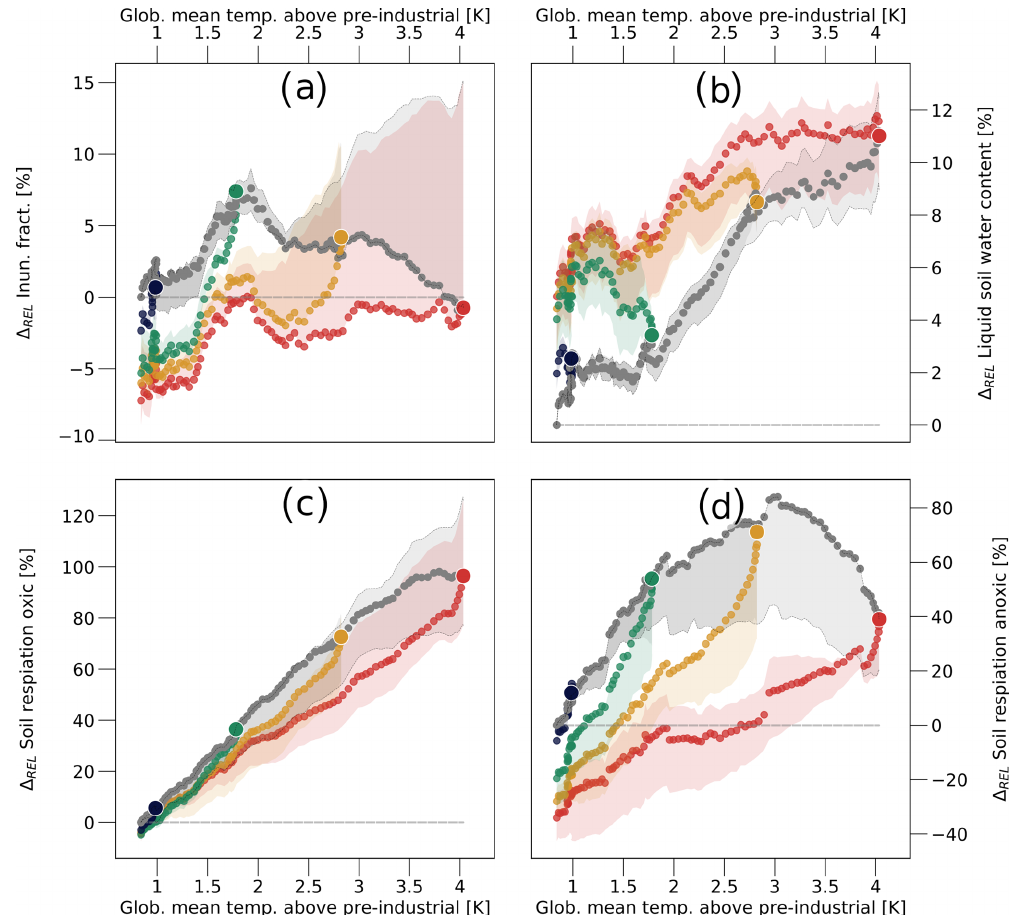
Figure 9. Soil CH 4 and CO 2 production in seasonally inundated areas. Relative change in (a) extent of inundated areas, (b) liquid water content of the soil, (c) oxic soil respiration and (d) soil methane production. Panel (a) shows the simple spatial average over permafrost- affected grid boxes, while (b–d) include a weighting by the (annual mean) wetland fraction. Colours and symbols have the same meaning as in Fig. 6.